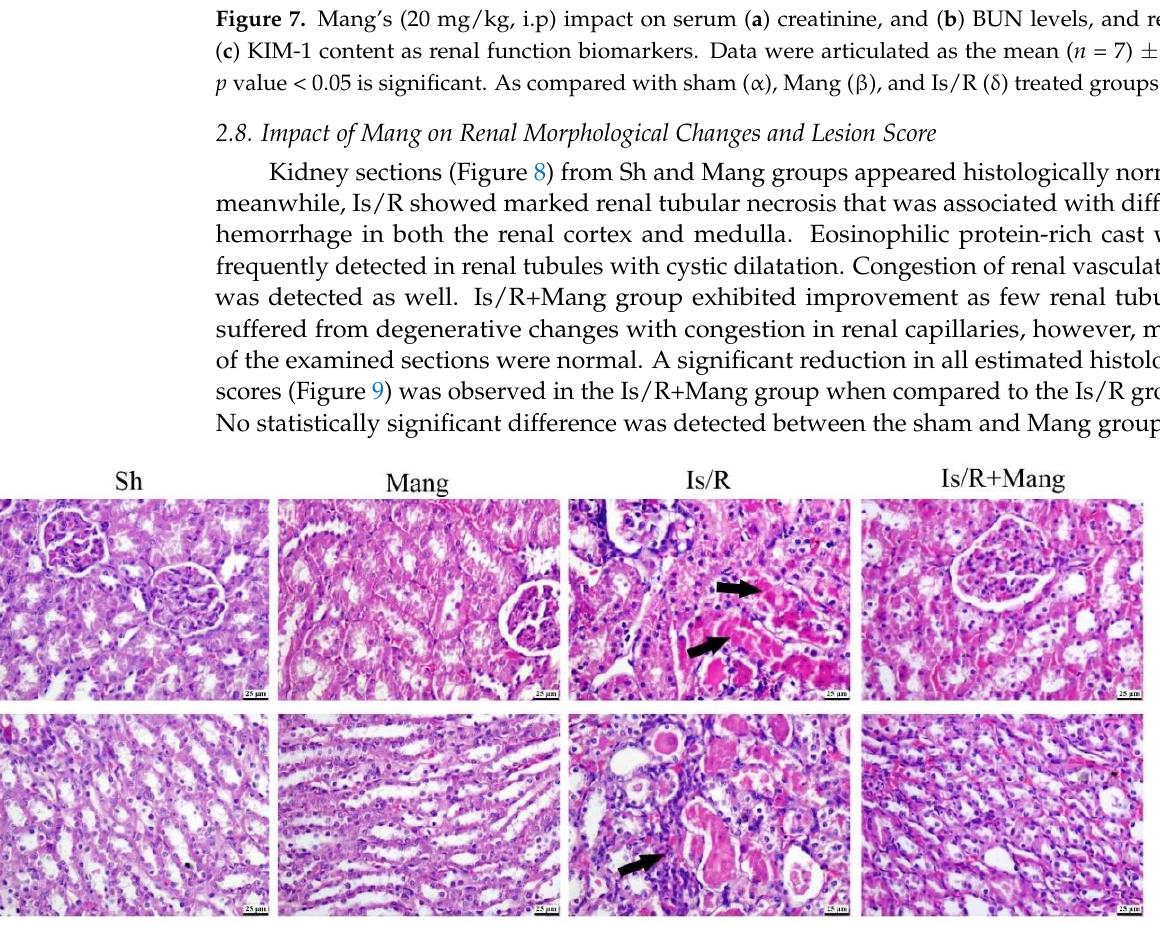
Figure 7. Mang ’s (20 mg/kg, i.p) impact on serum ( a ) creatinine, and ( b ) BUN levels, and renal ( c ) KIM-1 content as renal function biomarkers. Data were articulated as the mean ( n = 7) ± SD, p value< 0.05 is significant. As compared with sham (α ), Mang ( β), and Is/R (δ) treated groups.